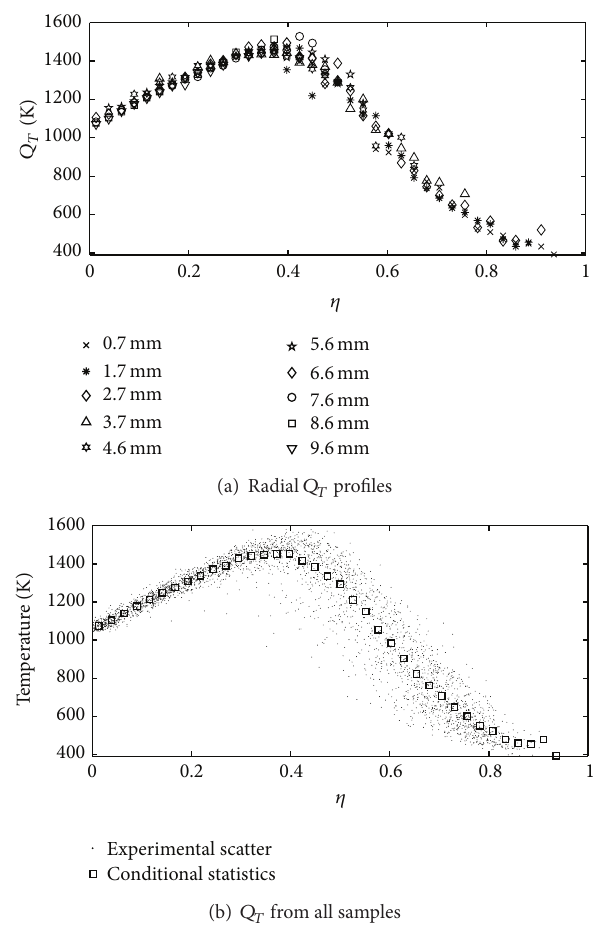
Figure 20: Computation of the conditional temperature from the experimental scatter at 𝑥/𝑑 = 14 : (a) profiles obtained from measurements at fixed radii (b) profile obtained from all samples superimposed over the experimental